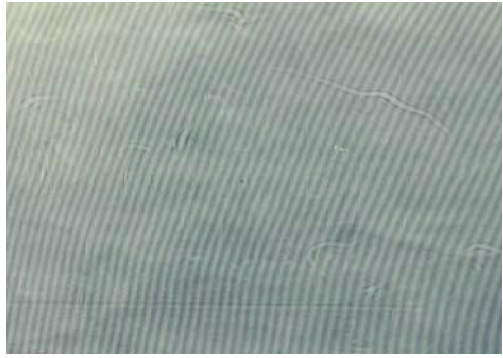
Figure 12: Results of the optical field